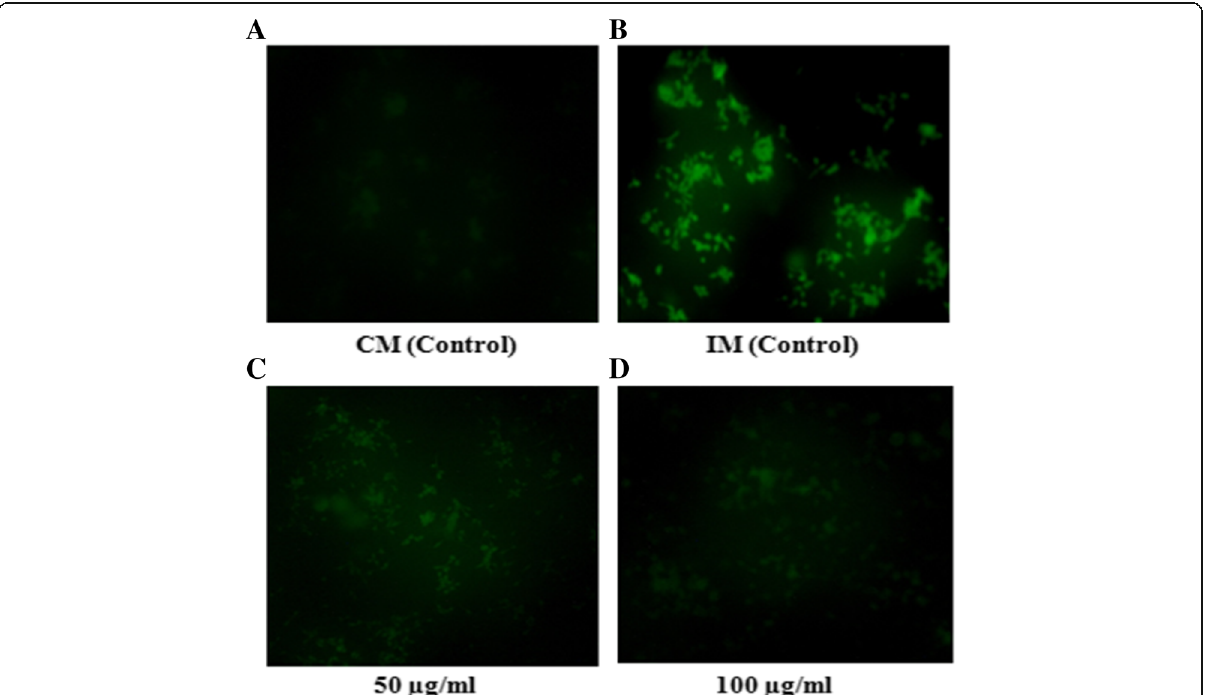
Fig. 4 Effects of AR rhizome extract on oxidative stress in the WRL-68 cells. a ) Unstressed cells grown in CM showed basal level ROS b ) Control cells grown in IM showing increased ROS generation c ) Cells in IM treated with 50 μ gml − 1 of extract d ) Cells in IM treated with 100 μ gml − 1 of